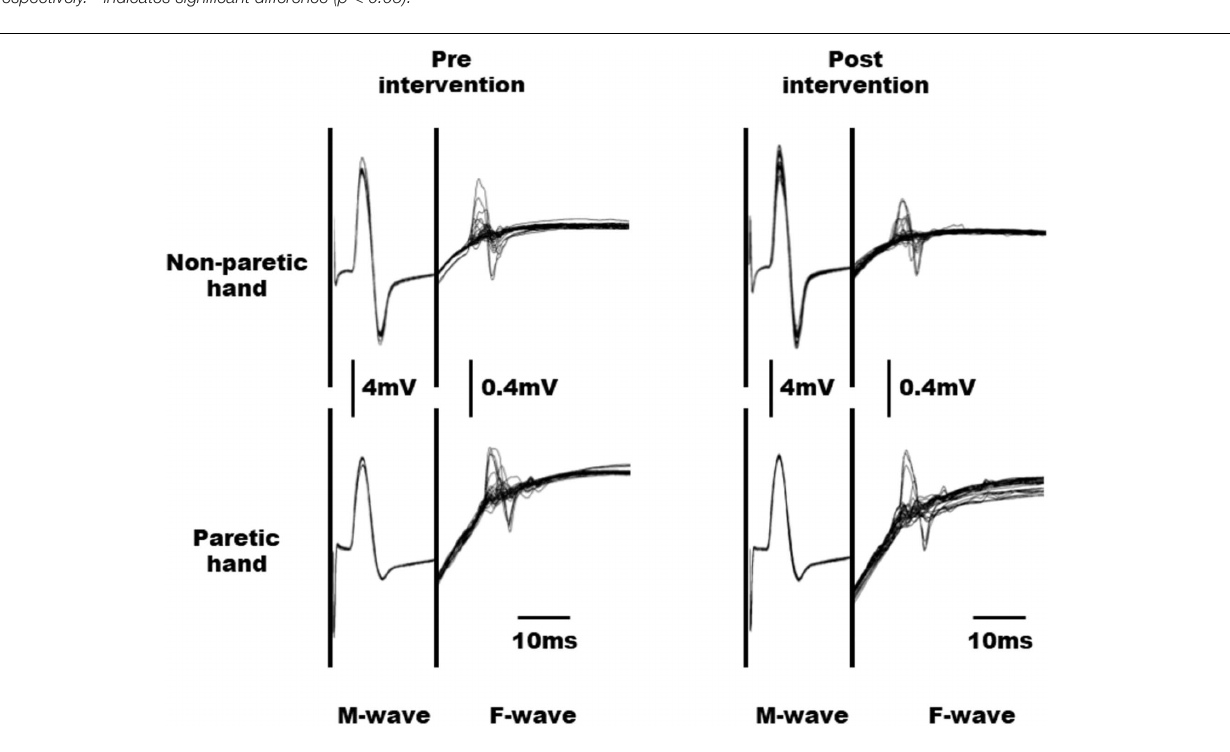
η 2 = 0.051; Table 3 ). Moreover, both time (F1, 6 = 0.482, n =